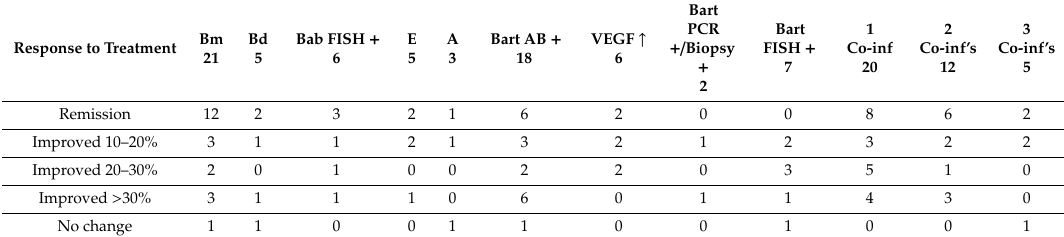
Table 1. Co-infection status and treatment response in 40 patients on DDD